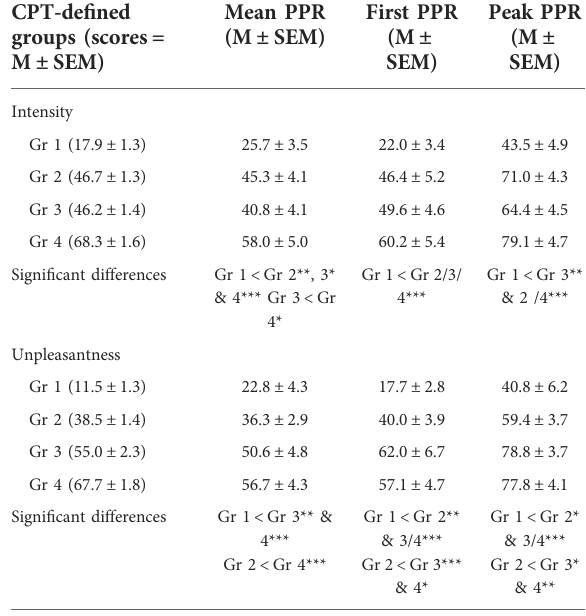
TABLE 2 PPR scores for CPT-PPR intensity and unpleasantness